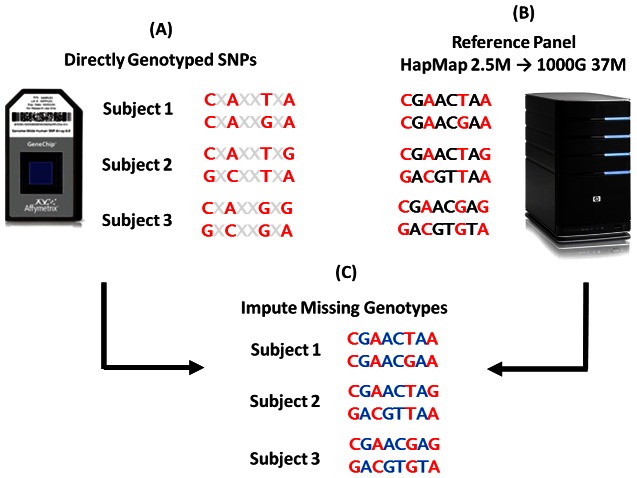
Schematic overview of imputation.(A) Directly genotyped SNPs are phased to estimate haplotypes that alleles reside on. (B) Publically available reference haplotypes from projects including the International HapMap Project and the 1000 Genomes Project are downloaded that contain variants to be imputed. (C) Phased haplotypes from the study are assessed and likened to publically available haplotypes. The most likely genotypes are imputed into the study based on the alleles found in reference haplotype panel.